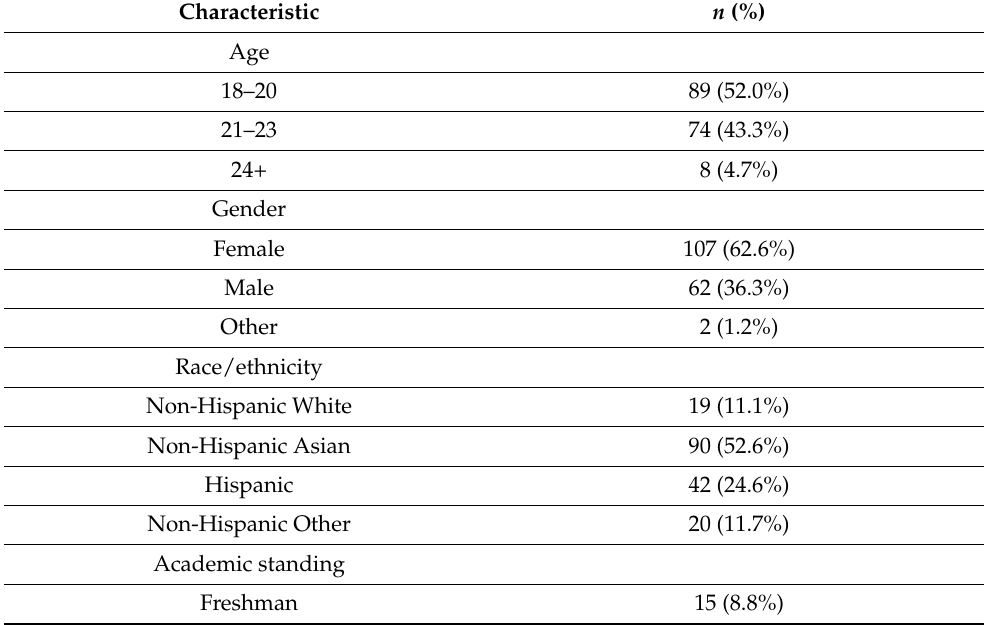
Table 1. Sample characteristics ( n =